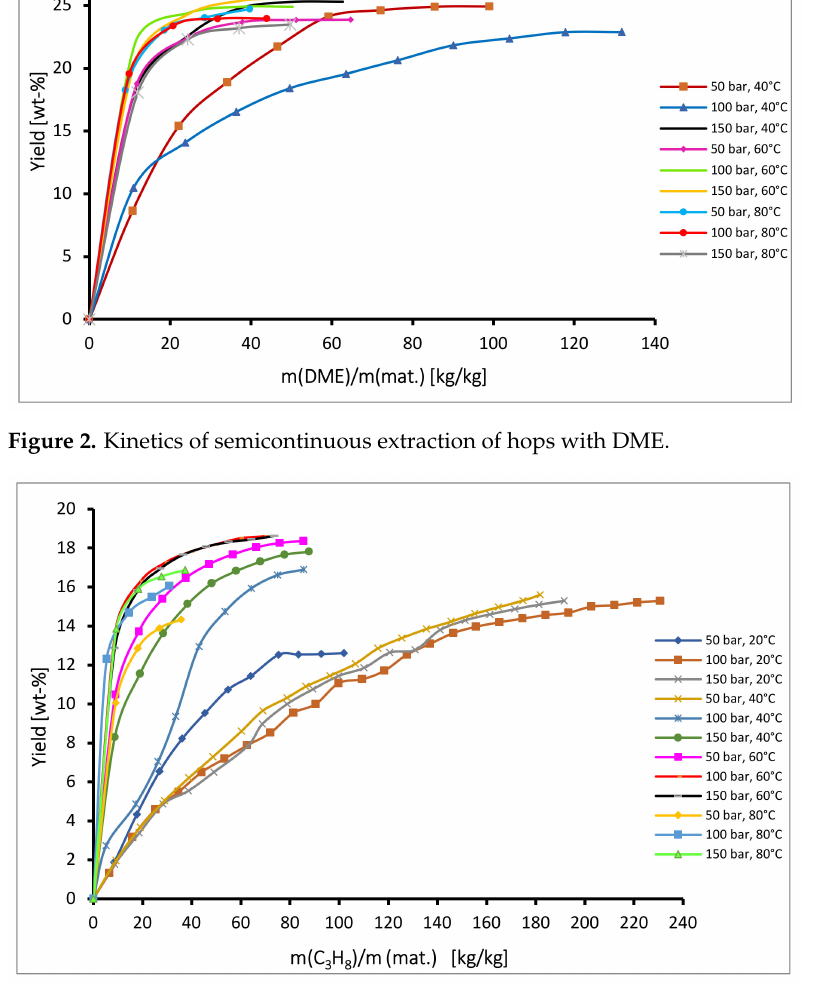
Figure 3. Kinetics of semi-continuous extraction of hops with